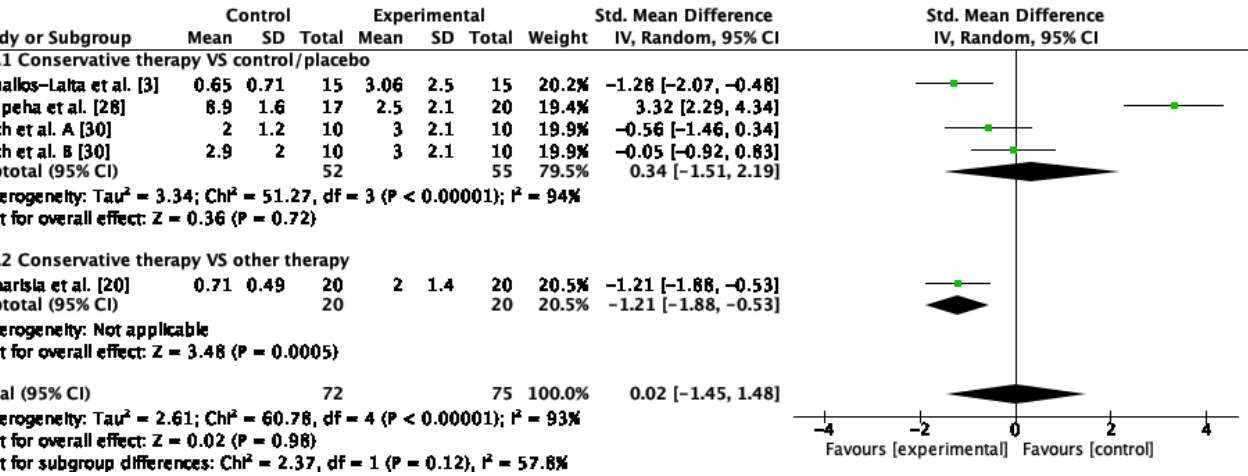
Figure 8. Forest plot of pain intensity for conservative therapy versus control/sham and conserva- tive therapy versus other conservative therapy. Lluch et al. A. compared manual therapy versus control intervention. Lluch et al. B compared the manual contact versus control intervention.